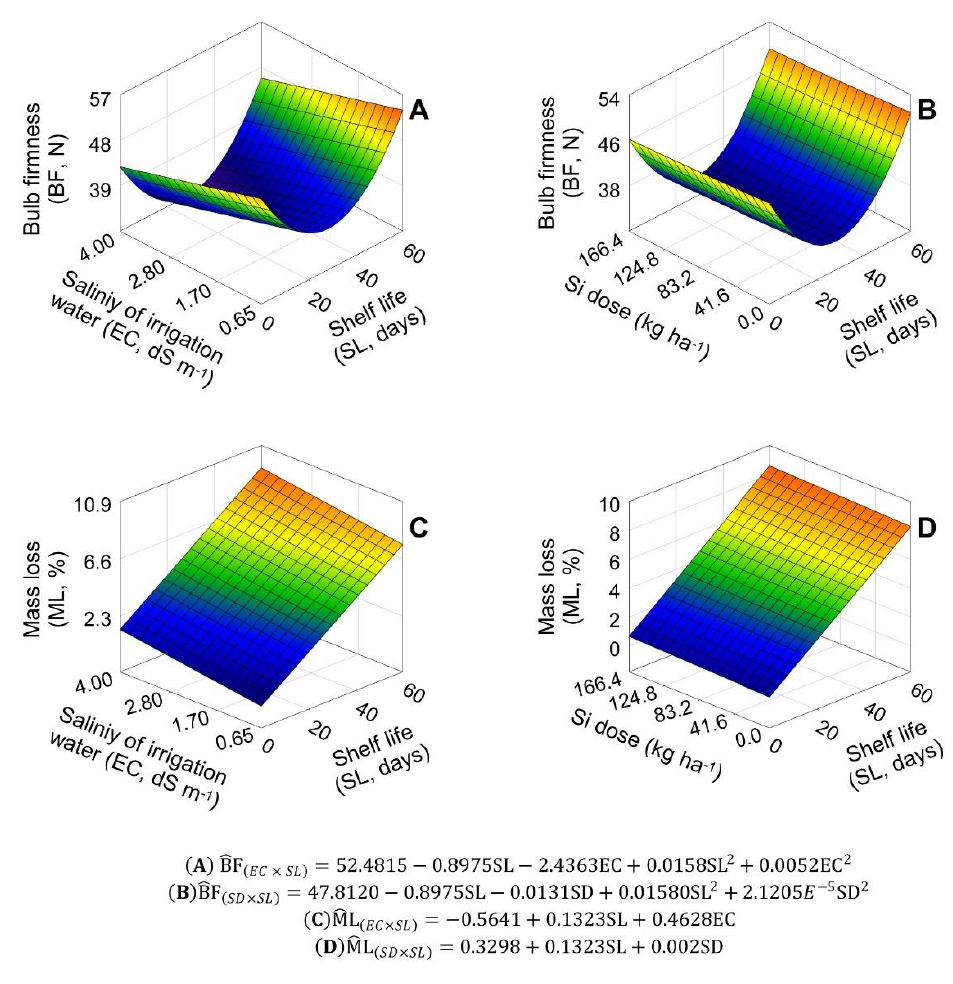
Figure 1. Unfolding of the treatment factors of salinity of irrigation water (EC) and silicon doses in the soil (SD), with shelf life (SL), for the variables: bulb firmness (FB, in N) ( A , B ); and mass loss (ML, %) ( C , D ), in ‘Rio da Antas’ onion bulbs.